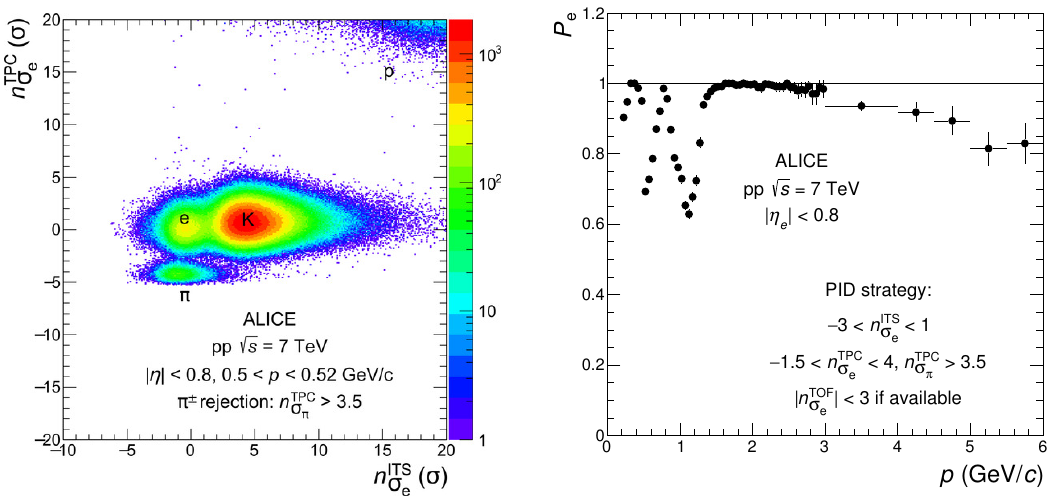
Figure 1 . (Colour online) TPC PID signal expressed as n TPC PID signal ( n ITS ) for selected tracks with 0.5 < p < 0.52 GeV/ c after applying the pion rejection in (cid:27) e the TPC (left). Electron purity P e as a function of momentum (right). Only statistical uncertainties are